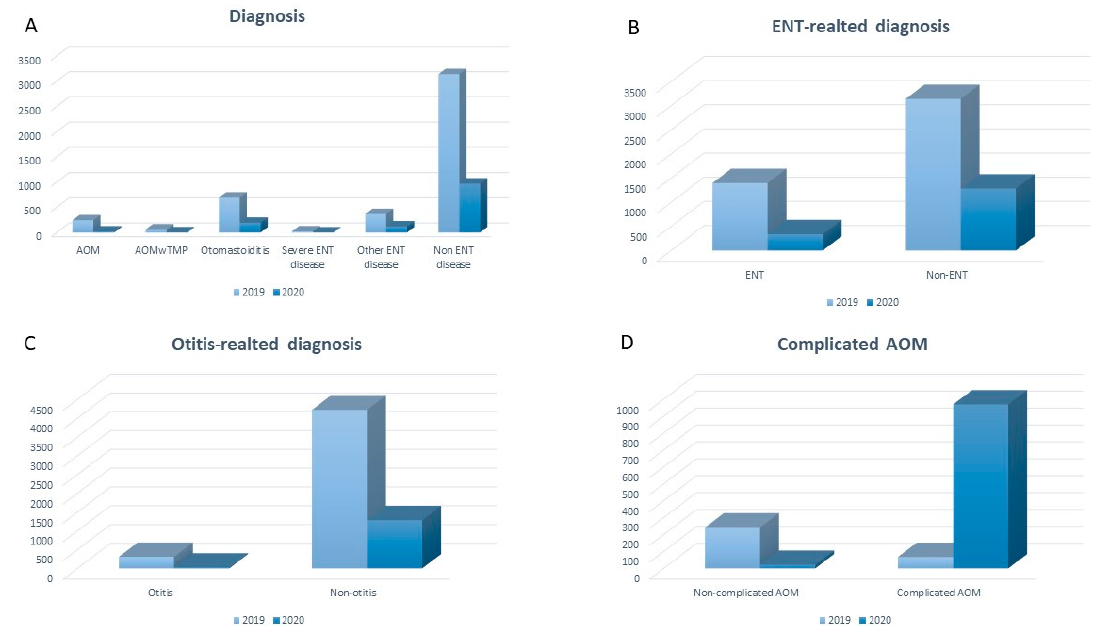
Figure 1. Distribution of all the diagnoses during the two study periods (( A ): absolute numbers); comparison between the number of ENT- and non-ENT-related diagnoses ( B ); otitis- and non-otitis-related diagnoses ( C ), diagnoses of complicated acute otitis media episodes and diagnoses of non-complicated acute otitis media episodes ( D ) during the two study periods (ENT: ear, nose, throat; AOM: acute otitis media).